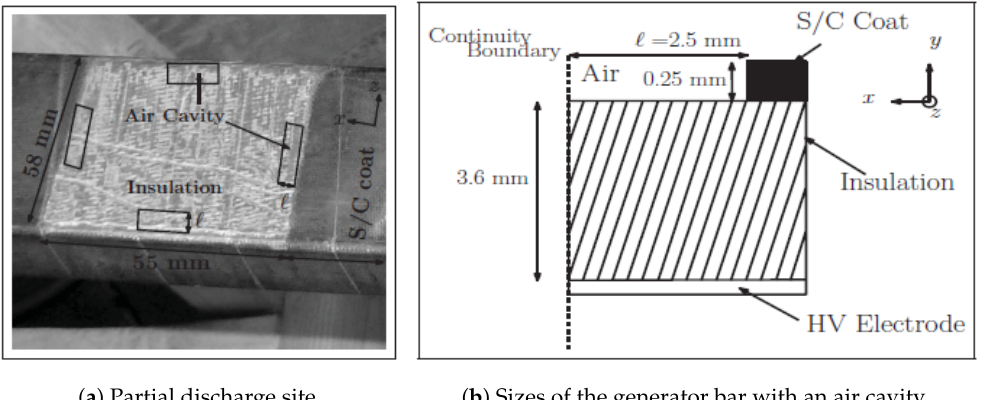
Figure 3. The plane of a generator bar with the designed air cavities